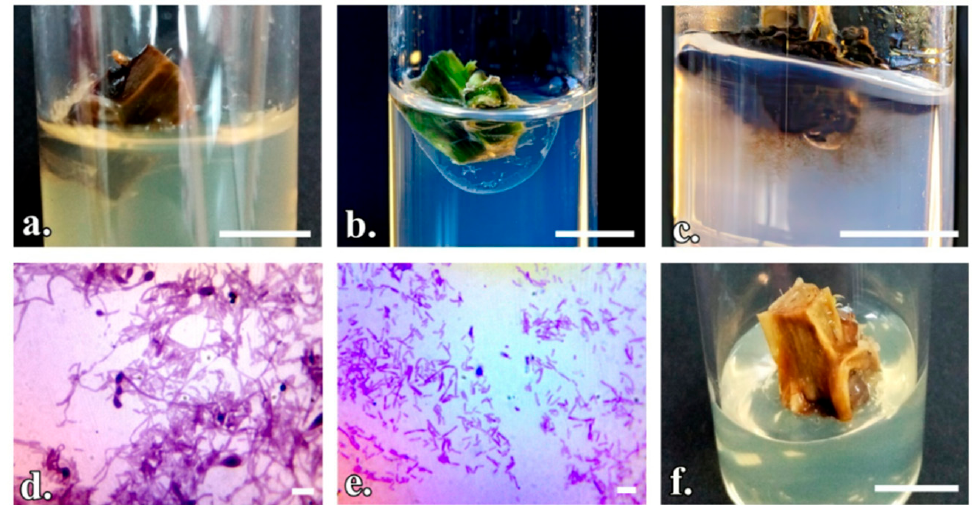
Figure 1. The behavior of P. quadrangularis explants after asepsis treatments: ( a ) Endogenous bacterial and fungal contamination (T1–T6); ( b ) Endogenous bacterial contamination (T10–T13); ( c ) Fungal contamination and the presence of phenols (T10–T13); ( d , e ) Bacterial and fungal contamination, 100 × magnification; ( f ) Explant affected by phytotoxicity. ( a – c , f ) Scale bar represents 1 cm; ( d , e ) Scale bar represents 10 µ